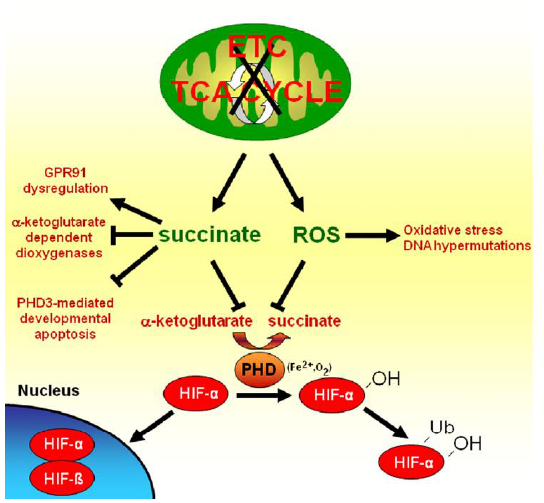
Figure 3: Mechanisms of tumorigenesis due to SDH inactivation